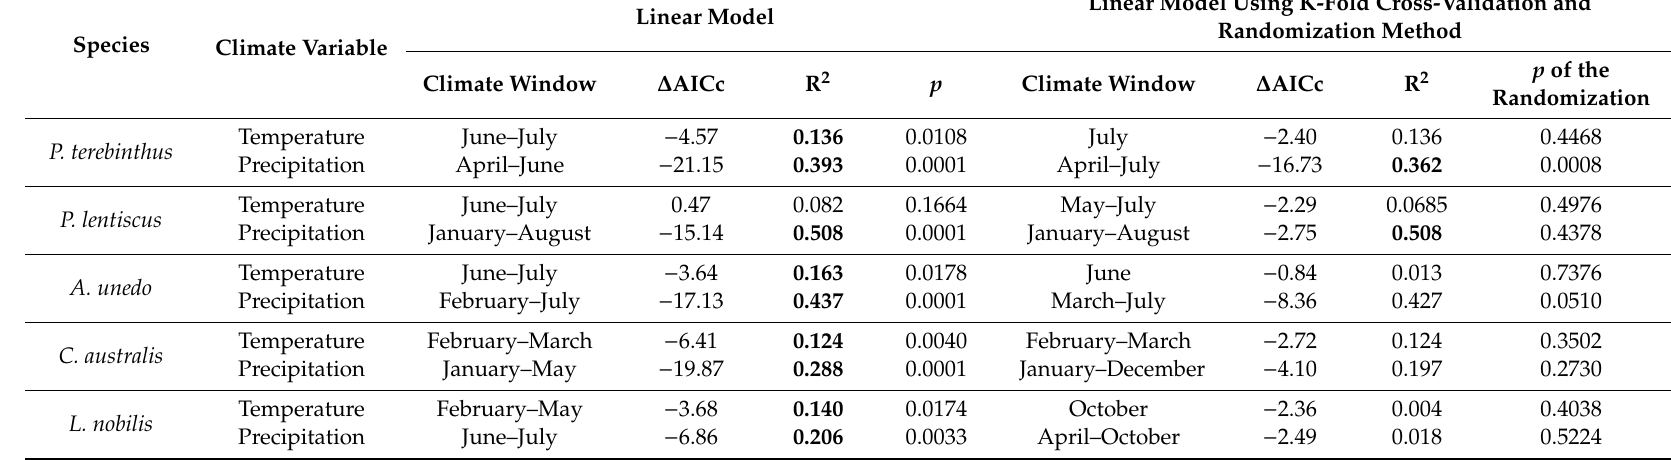
Table 3. Summary of the climate–growth relationships based on “ climwin” analyses. In all cases linear models and mean values of the climate variables were used. Significant ( p < 0.05) R 2 values are shown in bold characters. AICc: Akaike information